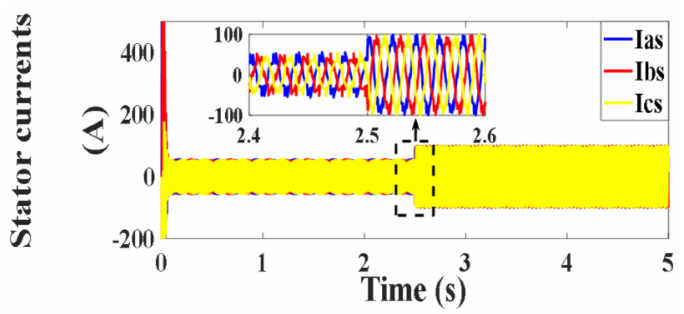
Figure 49. Stator currents under MPDTC (A).